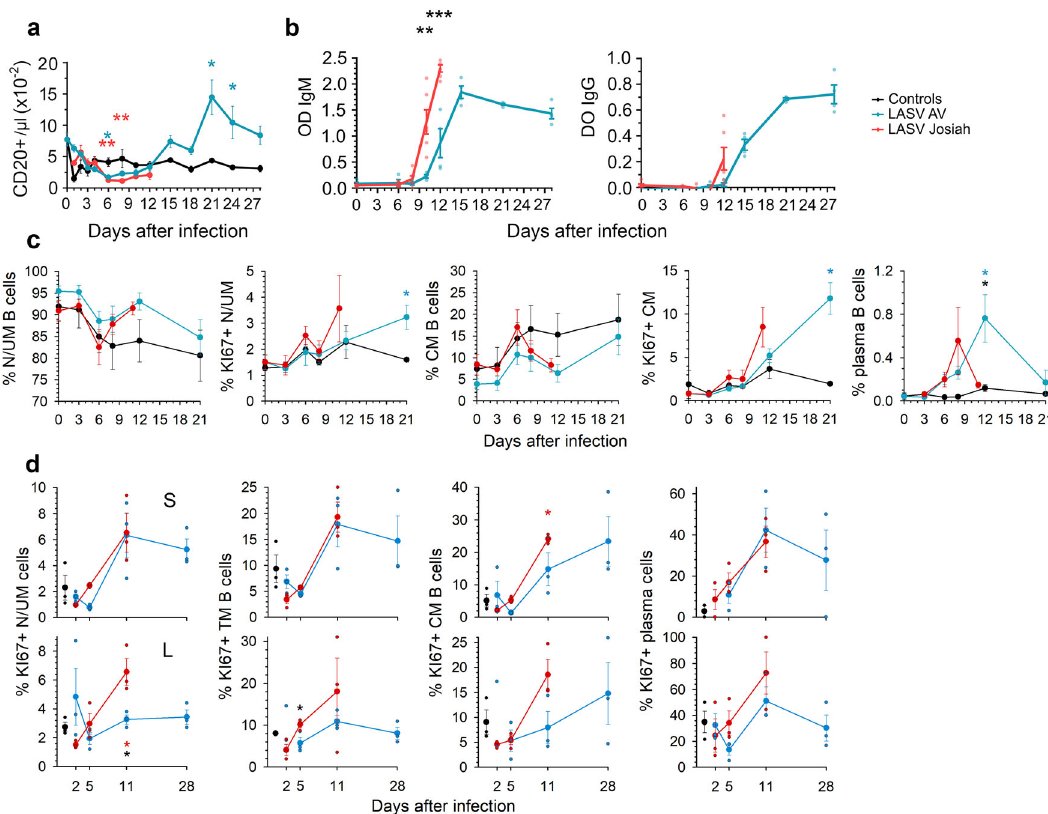
Fig. 5 Analysis of B-cell responses after LASV challenge. a The number of B cells (CD20 + ) in the blood is presented according to the time after LASV infection. Results show the mean ± SEM of control ( n = 3), AV ( n = 4), and Josiah ( n = 6) animals. b Detection of LASV-speci fi c IgM and IgG in animals after LASV infection by ELISA. Individual data (points) and mean values ± SEM for each cohort (curves) are presented. LASV-AV ( n = 4), LASV-Josiah ( n = 6). ** p < 0.01, *** p < 0.001, as determined by a Student ’ s t test. The percentage of naive/unconventional memory (N/UM) B cells (CD20 + CD38